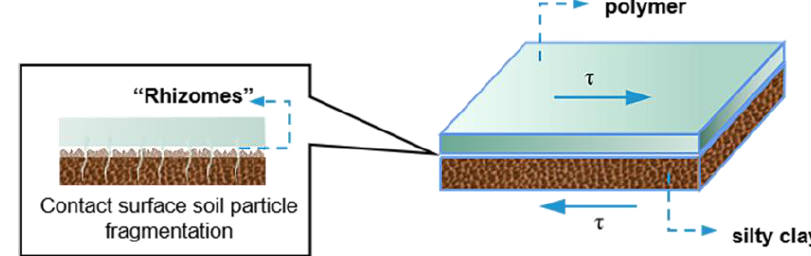
Figure 12. Breakage of soil particles on the interface of polymer – silty clay.